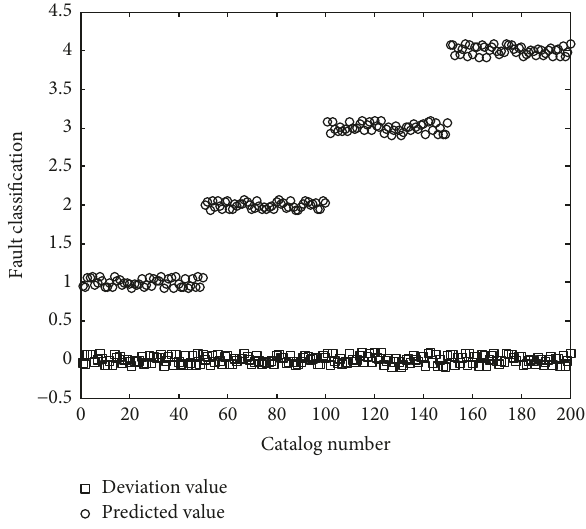
Figure 10: Prediction result of MKF 5th-degree CKF-SVR for 𝑅3 = 0.5